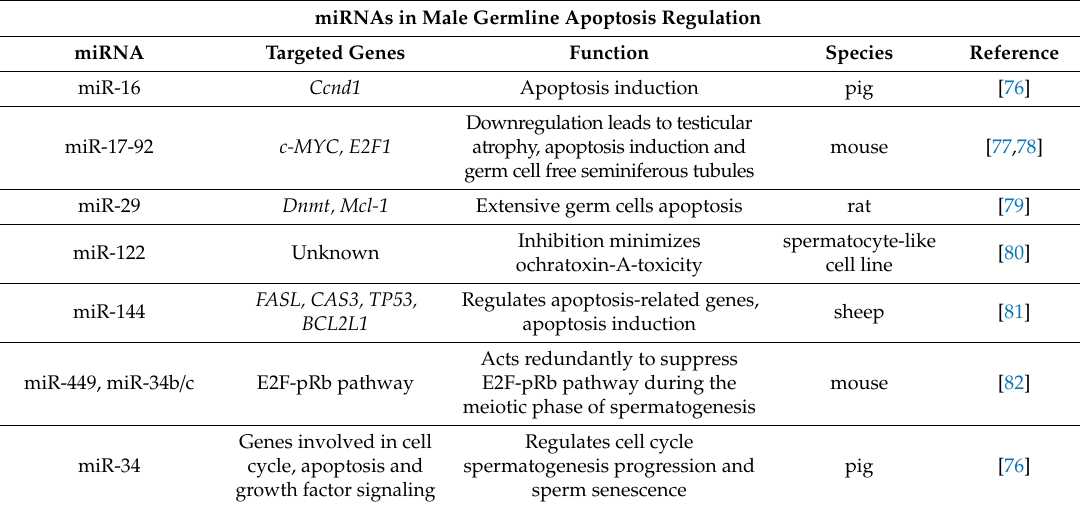
Table 1. miRNAs implicated in testicular function and germline